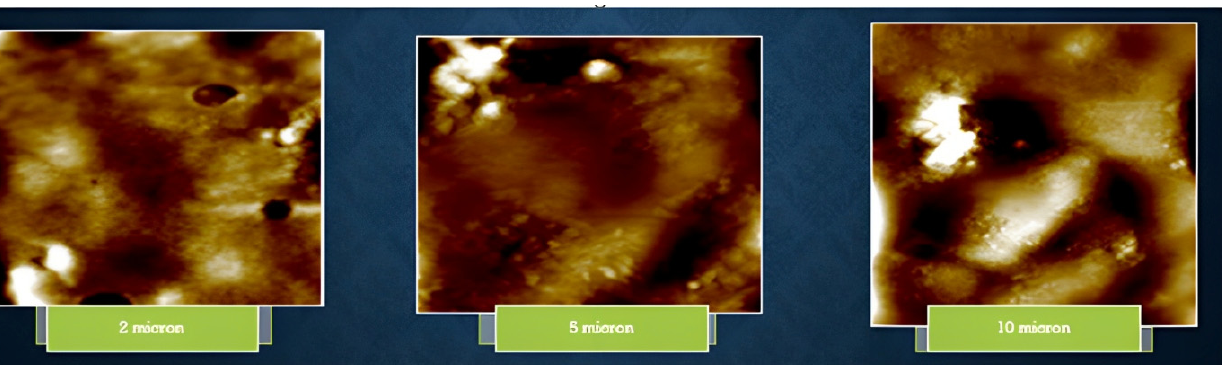
Figure 6. AFM images of CUI-P1 EPS molecules.